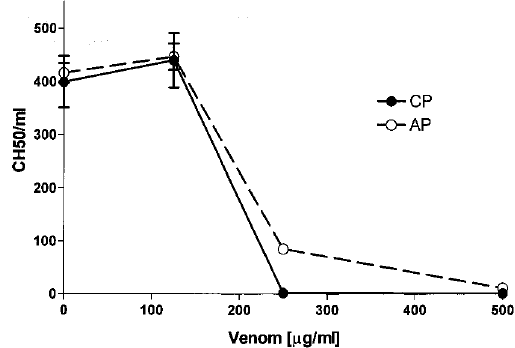
FIG. 1. Consumption of the haemolytic activity of the complement system following treatment with Bothrops asper venom (BaV). Samples of normal human serum (NHS) were incubated with different concentrations of venom for 30min at 37°C. Control samples were incubated with phos- phate-buffered solution (PBS) alone. Classical pathway (CP) activation of the complement system was determined by incubating aliquots of EA with dilutions of NHS in veronal- buffered saline (VBS) for 60min at 37°C. The plates were centrifuged to remove intact cells and the absorbance of the supernatant was measured at 414nm. Alternative pathway (AP) activation of the complement system was measured by using serum diluted in VBS containing EGTA-Mg ++ and rabbit E as target cells. Values are mean ± standard error (SE) of three experiments each performed in